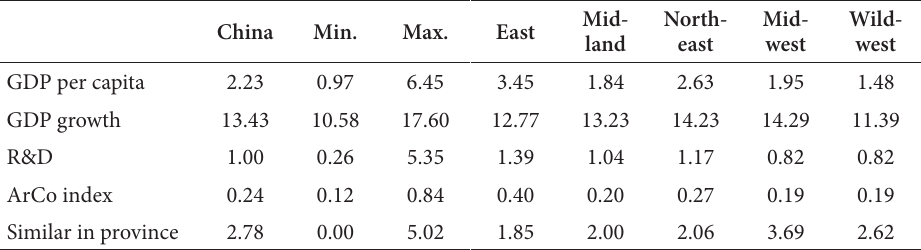
Table 6. Regional disparity of